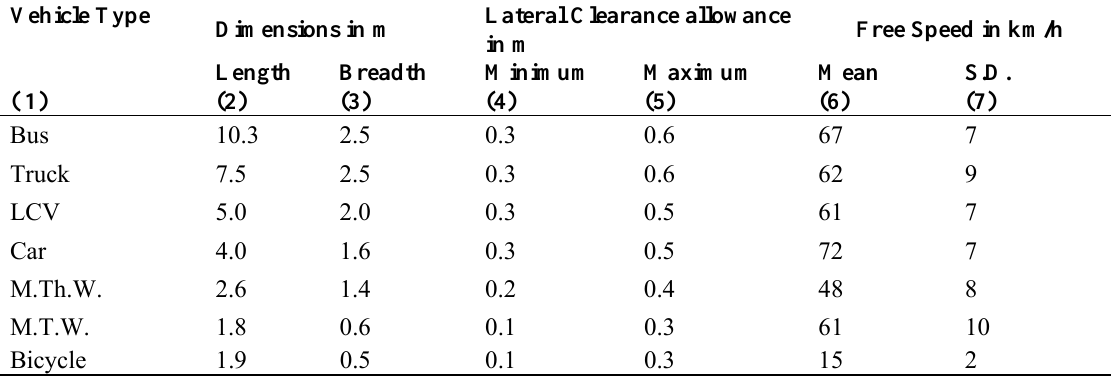
Table 1. Characteristics of vehicles of the heterogeneous traffic